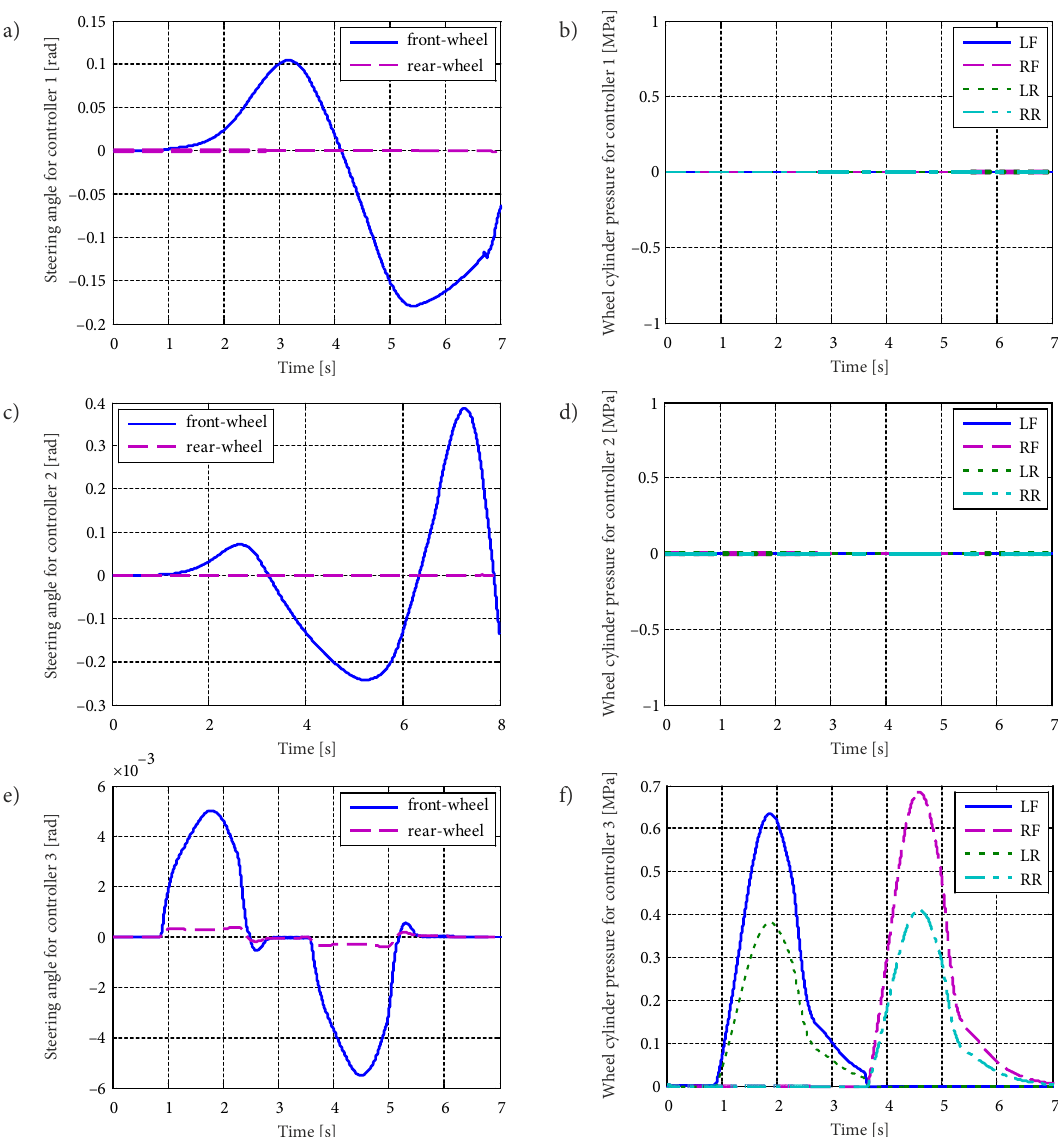
Figure 5. The steering angles and four brake cylinder pressures in the anti-crosswind simulation: a, b – red vehicle; c, d – blue vehicle; e, f – green